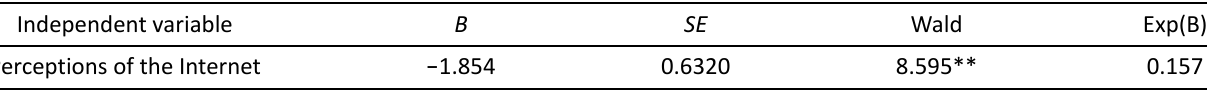
Table 2. Logistic regression results for predicting the motivation to join the course to become familiar with new technologies.